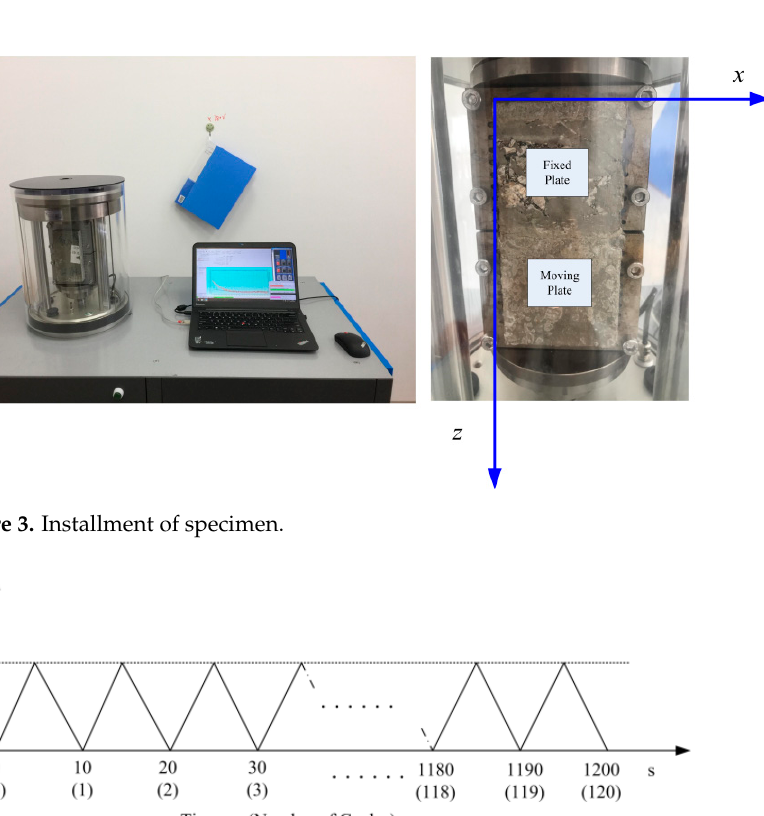
Figure 2. Cutting Template.